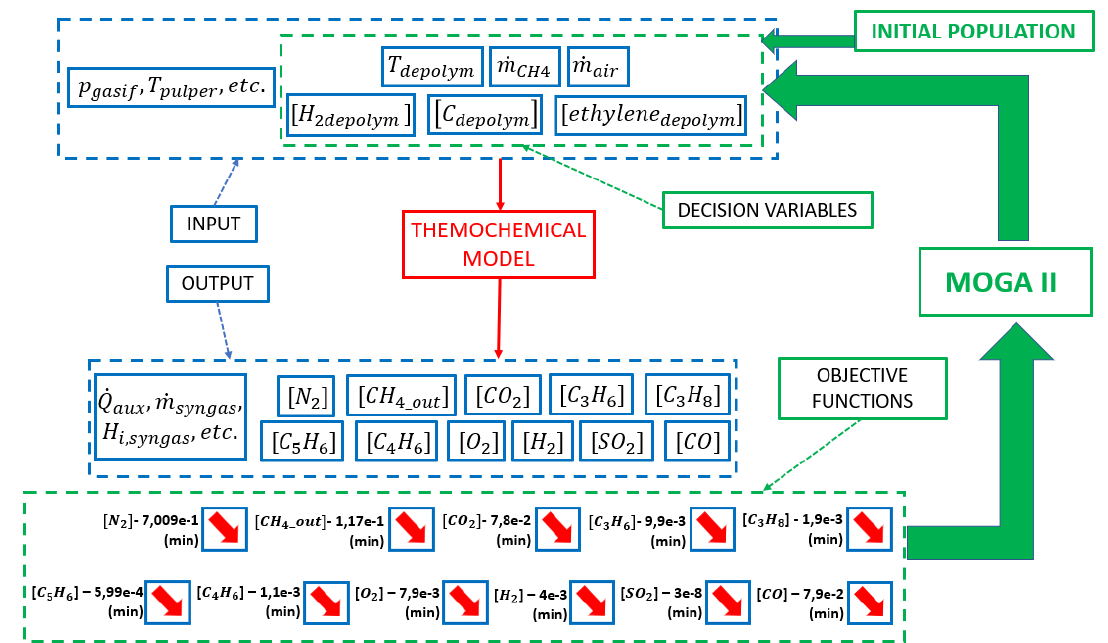
Figure 5. Logic scheme of the model calibration methodology.